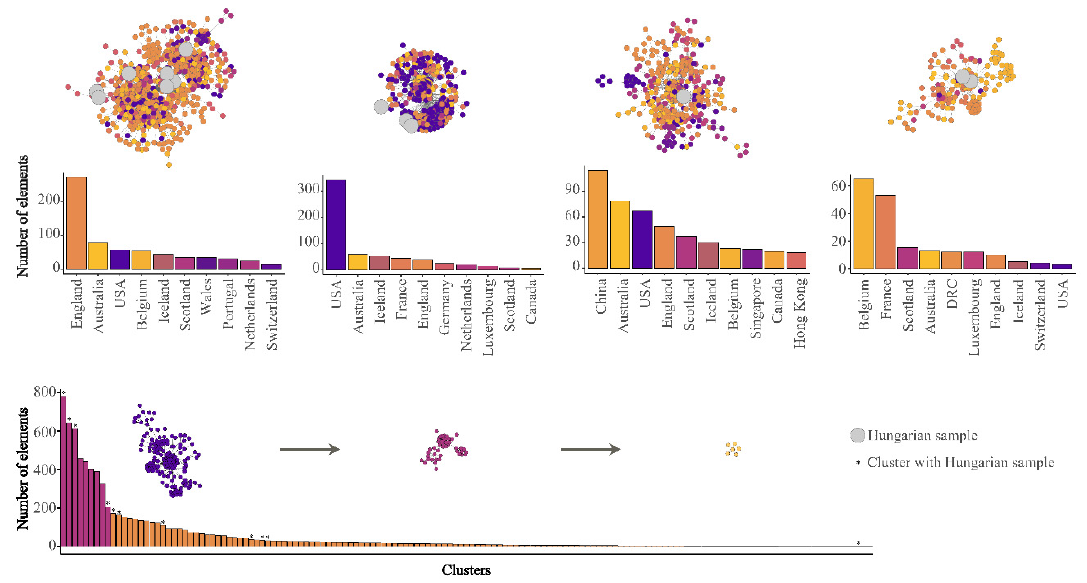
Figure 2. Representation of four main clusters which contain Hungarian SARS-CoV-2 genomes as of 21 April 2020. The ten most common countries of each cluster are summarized in a column graph and represented using different colors. Hungarian sequences are depicted by enlarged grey dots. Number of elements within each remaining ( n = 147) smaller cluster is indicated as a simple column chart at the bottom of the figure.